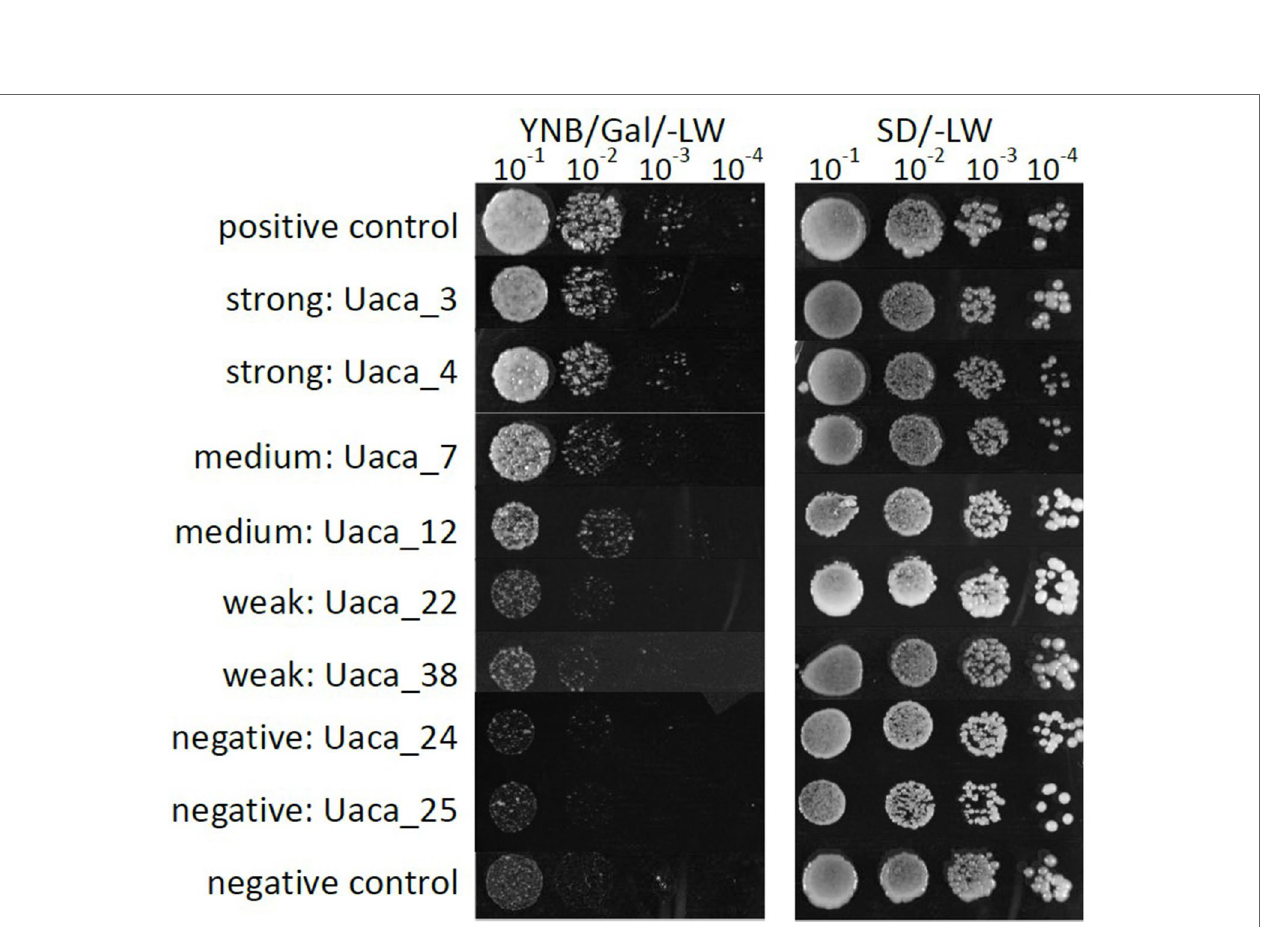
FIGURE 3 | Examples of phenotypes of the yeast cell death suppression assay. Growth phenotypes of serial dilutions of yeast strains grown on medium that induced the expression of bax . Uaca_Ns with representative phenotypes were chosen for display. Strong suppression was defined by growth detected at the 10 −4 dilution, Medium suppression was defined by growth detected at the 10 −3 dilution, Weak suppression was defined by growth at the 10 −1 or 10 −2 dilution, and Non- suppression by no growth at any dilution. This assay was performed two independent